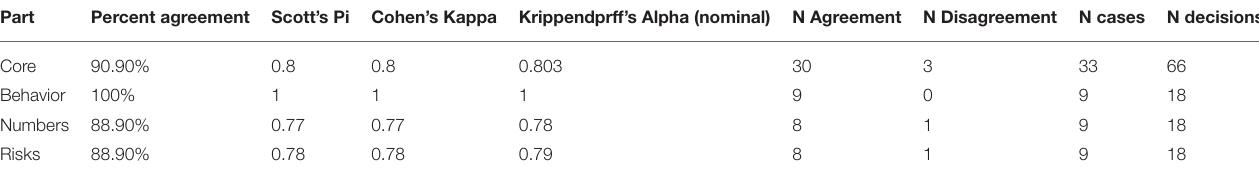
TABLE 5 | Total scores = 0.843 (4